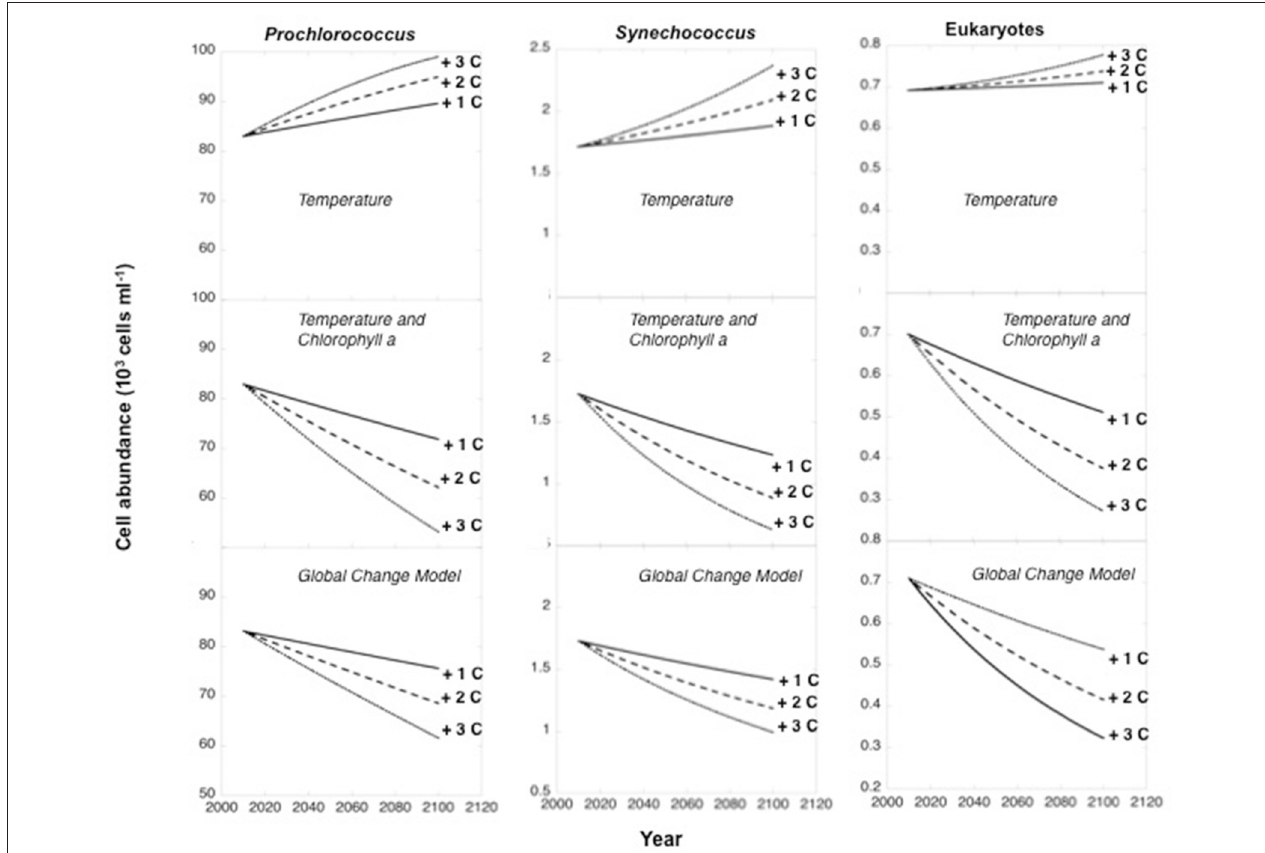
FIGURE 6 | Projected changes with time in the abundance of Prochlorococcus , Synechococcus , and picoeukaryotes from mean present values to forecast abundances at year 2100. Three scenarios of warming were considered by increasing the mean temperature obtained for the mixed layer in the survey (22.61 ◦ C) by 1 ◦ C (continuous lines), 2 ◦ C (dashed lines), and 3 ◦ C (dotted lines) by the end of the century. Each three series of panels considers three scenarios of prediction: thermal increase only, increased temperature and the decline in Chl a associated to warming (oligotrophication), and the global change model considering thermal increase, decrease in Chl a due to oligotrophication and the consequent increase in PAR and UVB levels. Forecasts were generated using fitted equations of regression models ( Table 2 ). Present abundance values represent the mean values obtained for the global ocean in the Malaspina-2010